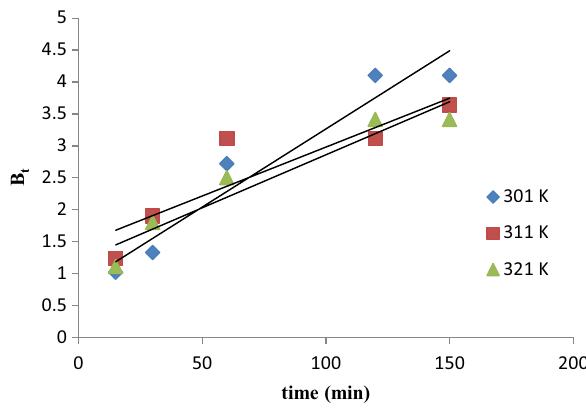
Fig. 12 Boyd kinetic plots for adsorption of CR dye on MSC at dif- ferent